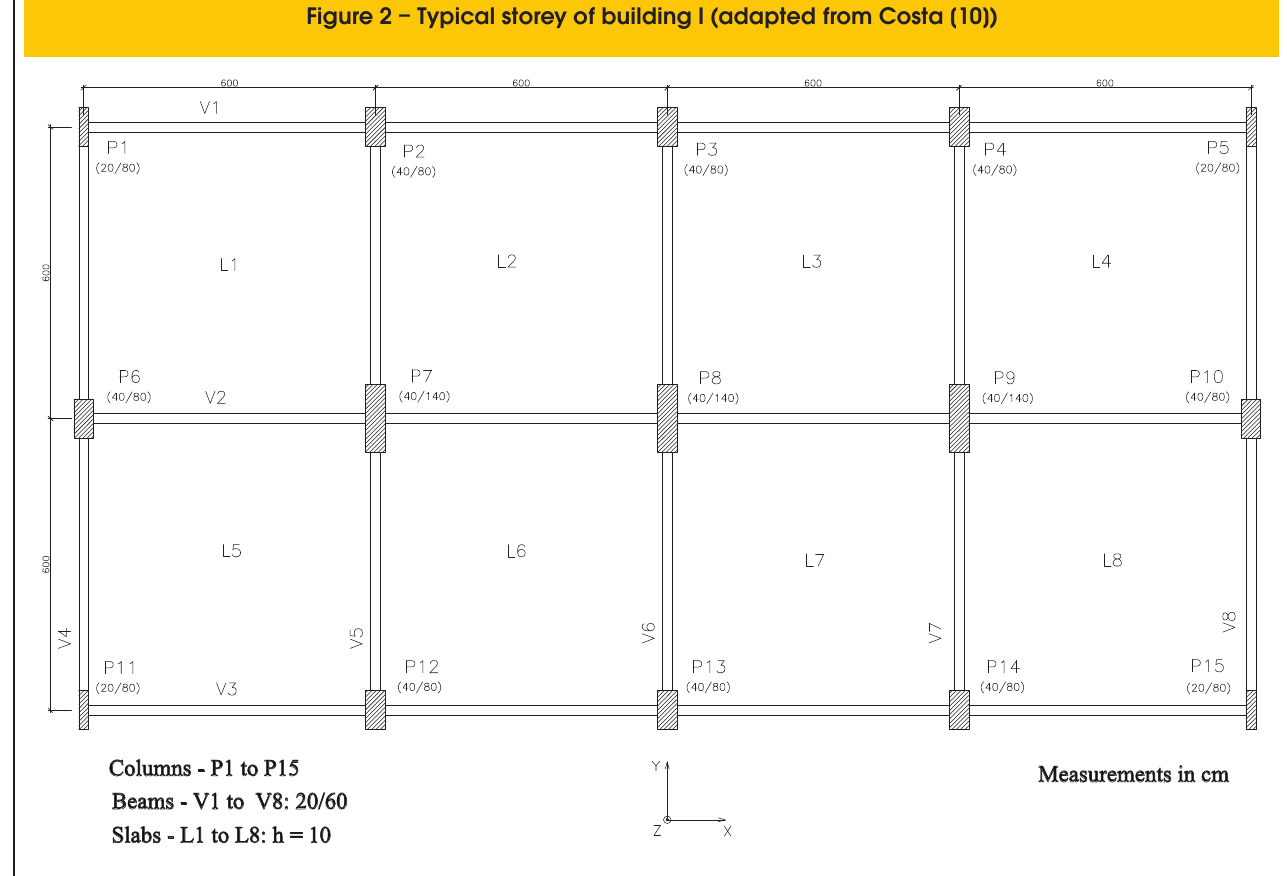
Table [1] sums up the main characteristics of the models